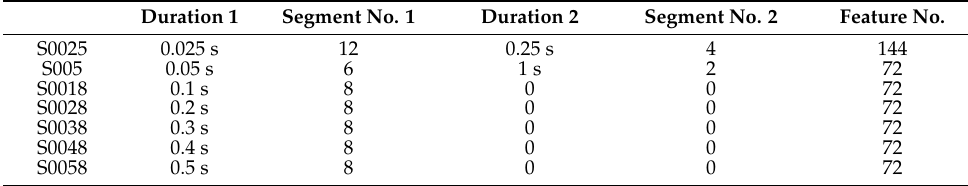
Table 2. The strategies of multi-segment feature